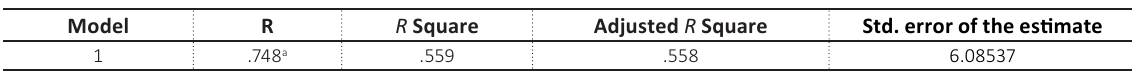
Table 6. Model summary